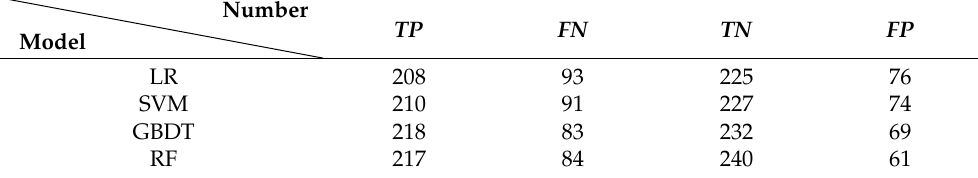
Figure 8. Evaluation of the prediction accuracy of each model. ( a ) Statistical accuracy indexes of each model. ( b ) ROC curve and AUC value of each model. Table 3. The confusion matrix for each model in the test set.